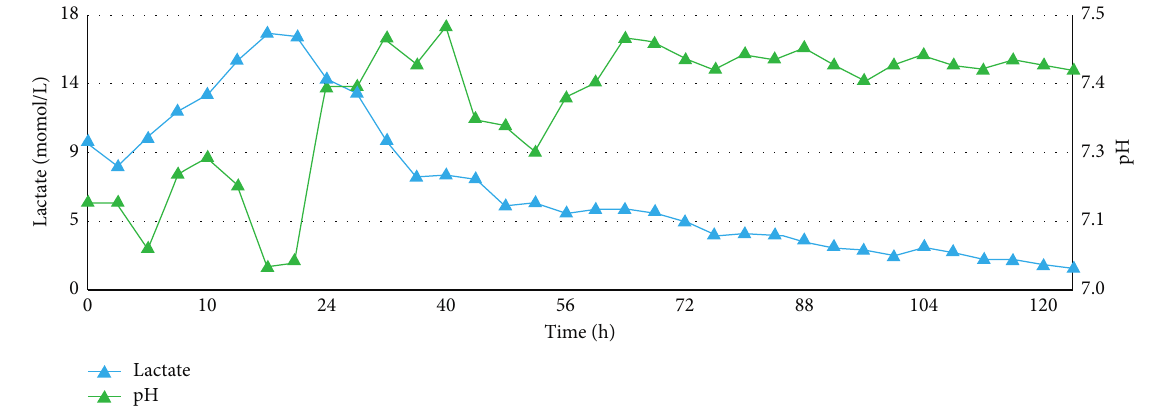
Figure 1: Trend showing lactate and pH values with time. Table 1: Trend of vital signs and dose of vasopressors after initiation of venoarterial extracorporeal membrane